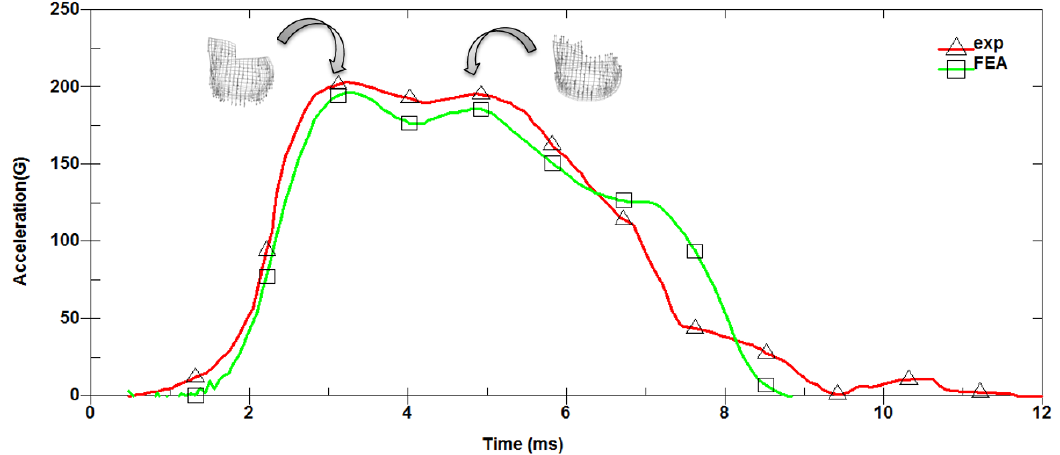
Figure 7. Comparison of simulated and experimental acceleration profiles for a full-face helmet.